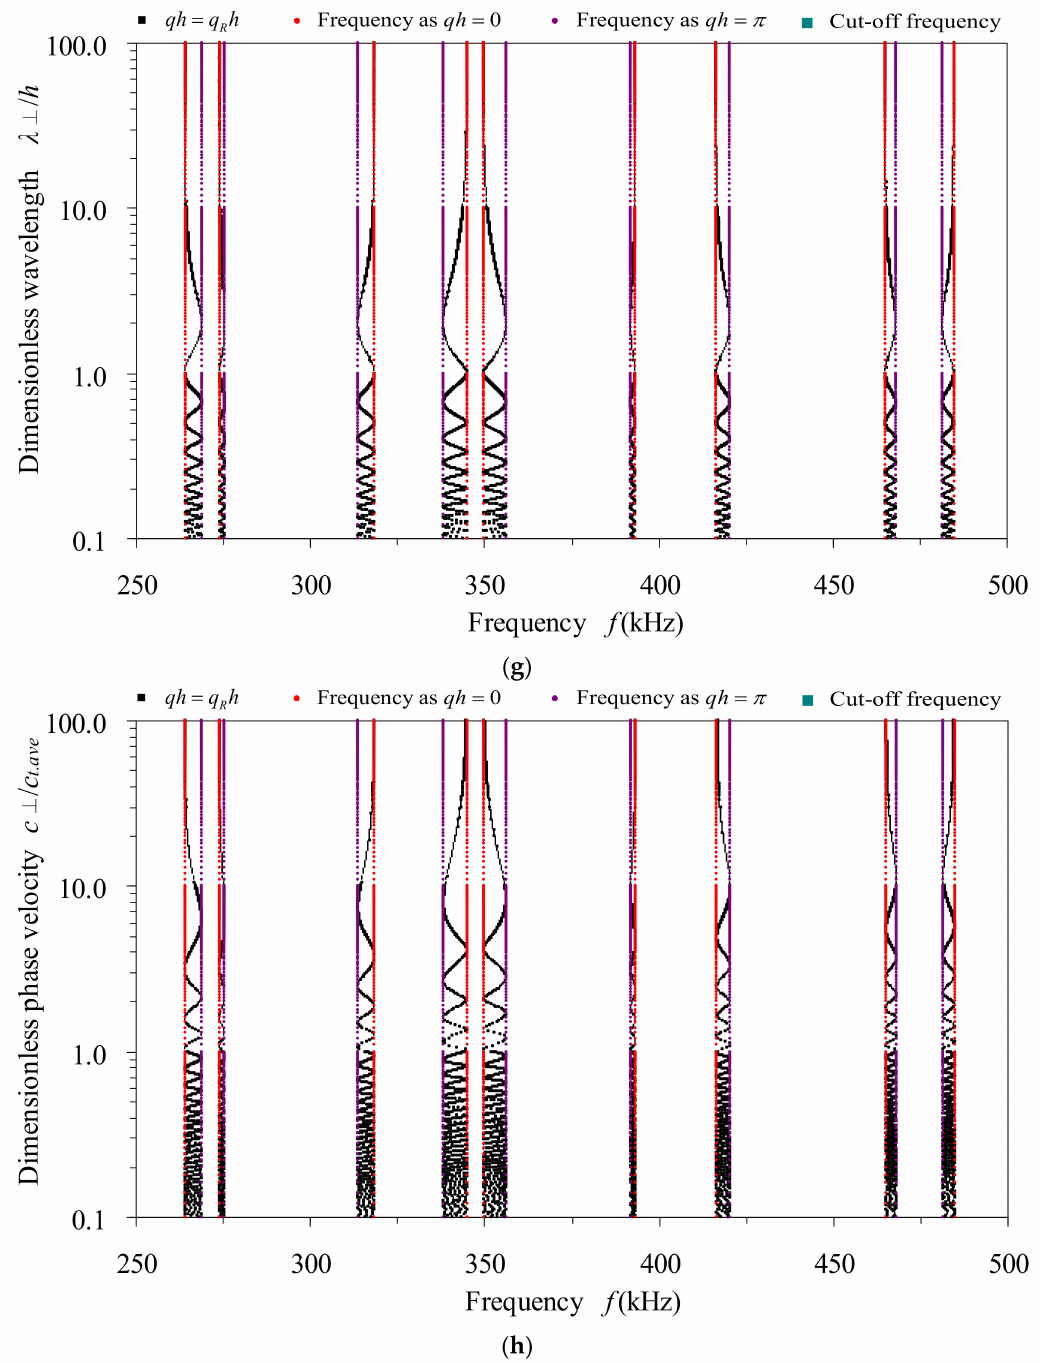
Figure 7. The comprehensive dispersion curves of Floquet in–plane waves propagating obliquely to layering in the exemplified periodically octal–layered media. The frequency–related dispersion curves in the low frequency range: ( a ) the frequency–wavenumber spectra, ( b ) the frequency–wavelength spectra, and ( c ) the frequency–phase velocity spectra. The other phase velocity–related dispersion curves: ( d ) the wavenumber–phase velocity curves, ( e ) the wavelength–phase velocity curves. The frequency–related dispersion curves within high frequency ranges: ( f ) the frequency–wavenumber spectra, ( g ) the frequency–wavelength spectra, and ( h ) the frequency–phase velocity